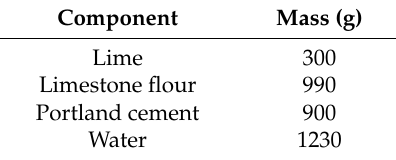
Table 1. NRVB composition.